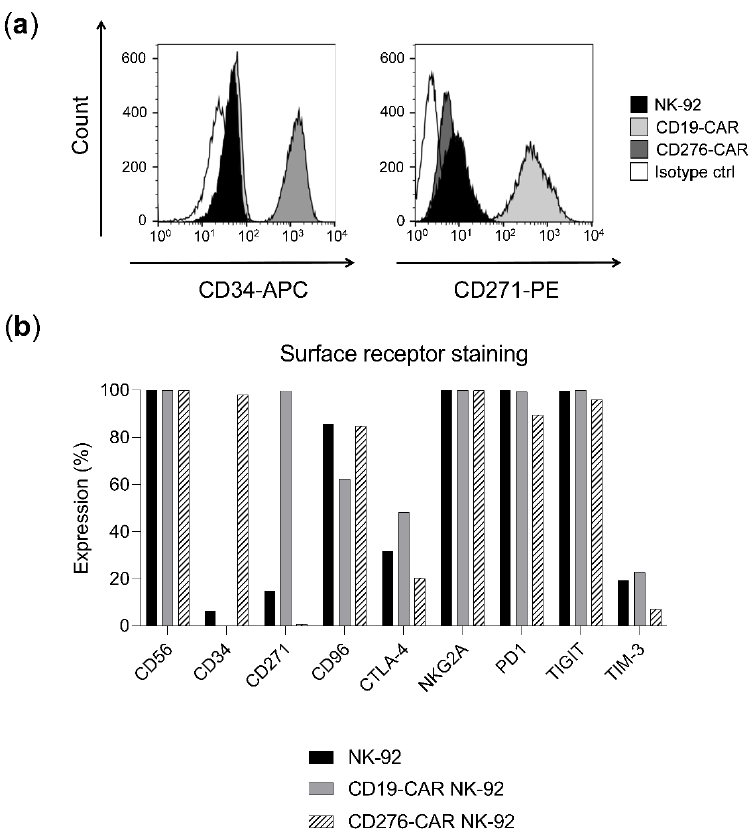
Figure 2. Receptor profile characterization of NK-92 cell lines. Percentage of receptor-expressing cells was determined by flow cytometry. ( a ) Expression of CAR reporter genes (CD34 and CD271) in NK-92 (black), CD19-CAR NK-92 (light grey), CD276-CAR NK-92 (dark grey) and NK-92 isotype control (white). ( b ) Receptor expression in NK-92 (black), CD19-CAR (grey) and CD276-CAR-NK-92 cell lines (white).